Question: From the figure, is the trend upward or downward?
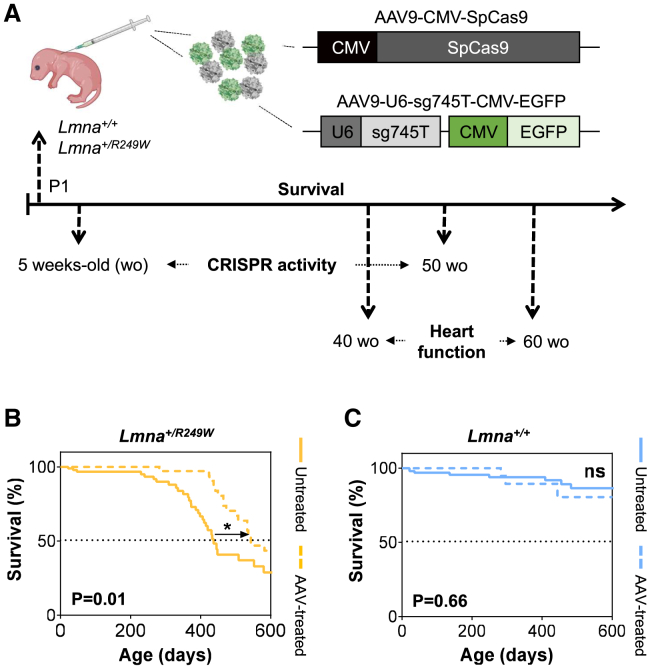
Answer: increasing